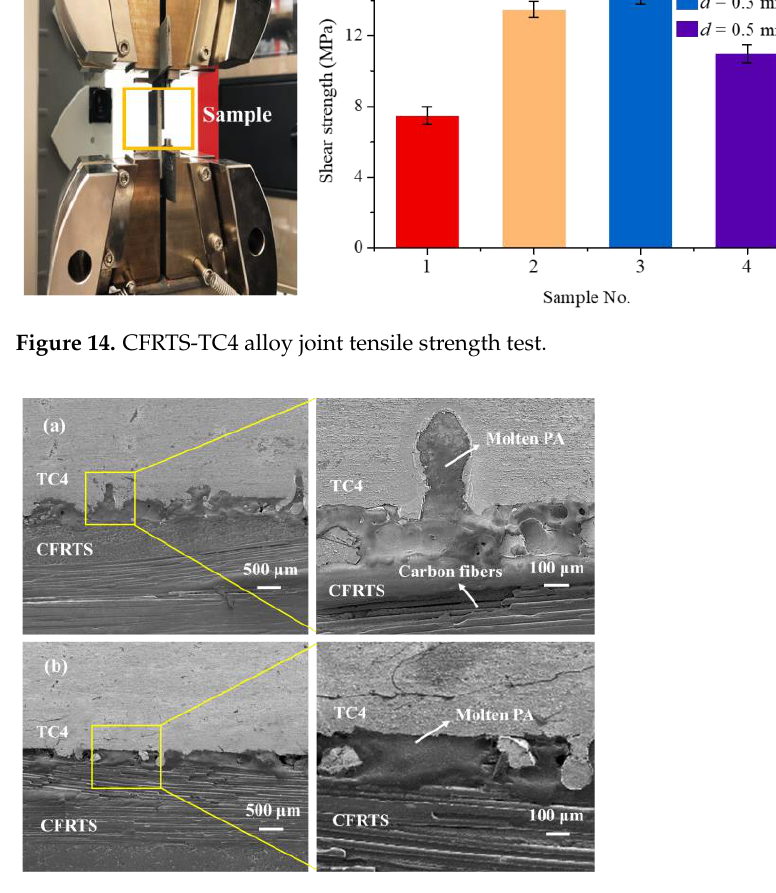
Figure 16. ( a , b ): Fracture surface morphology of sample 3; ( c , d ): fracture surface morphology of sample 4.